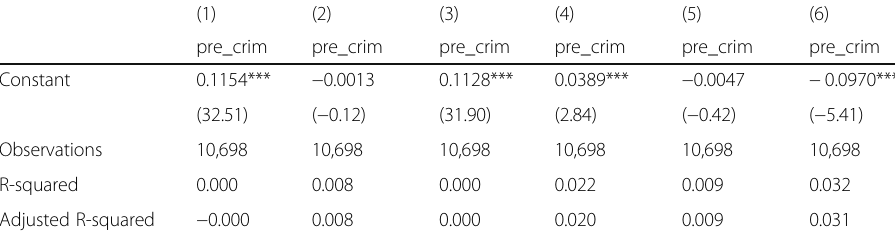
Table 19 Question-level correlates of criminal background in hired population (customer service and sales)